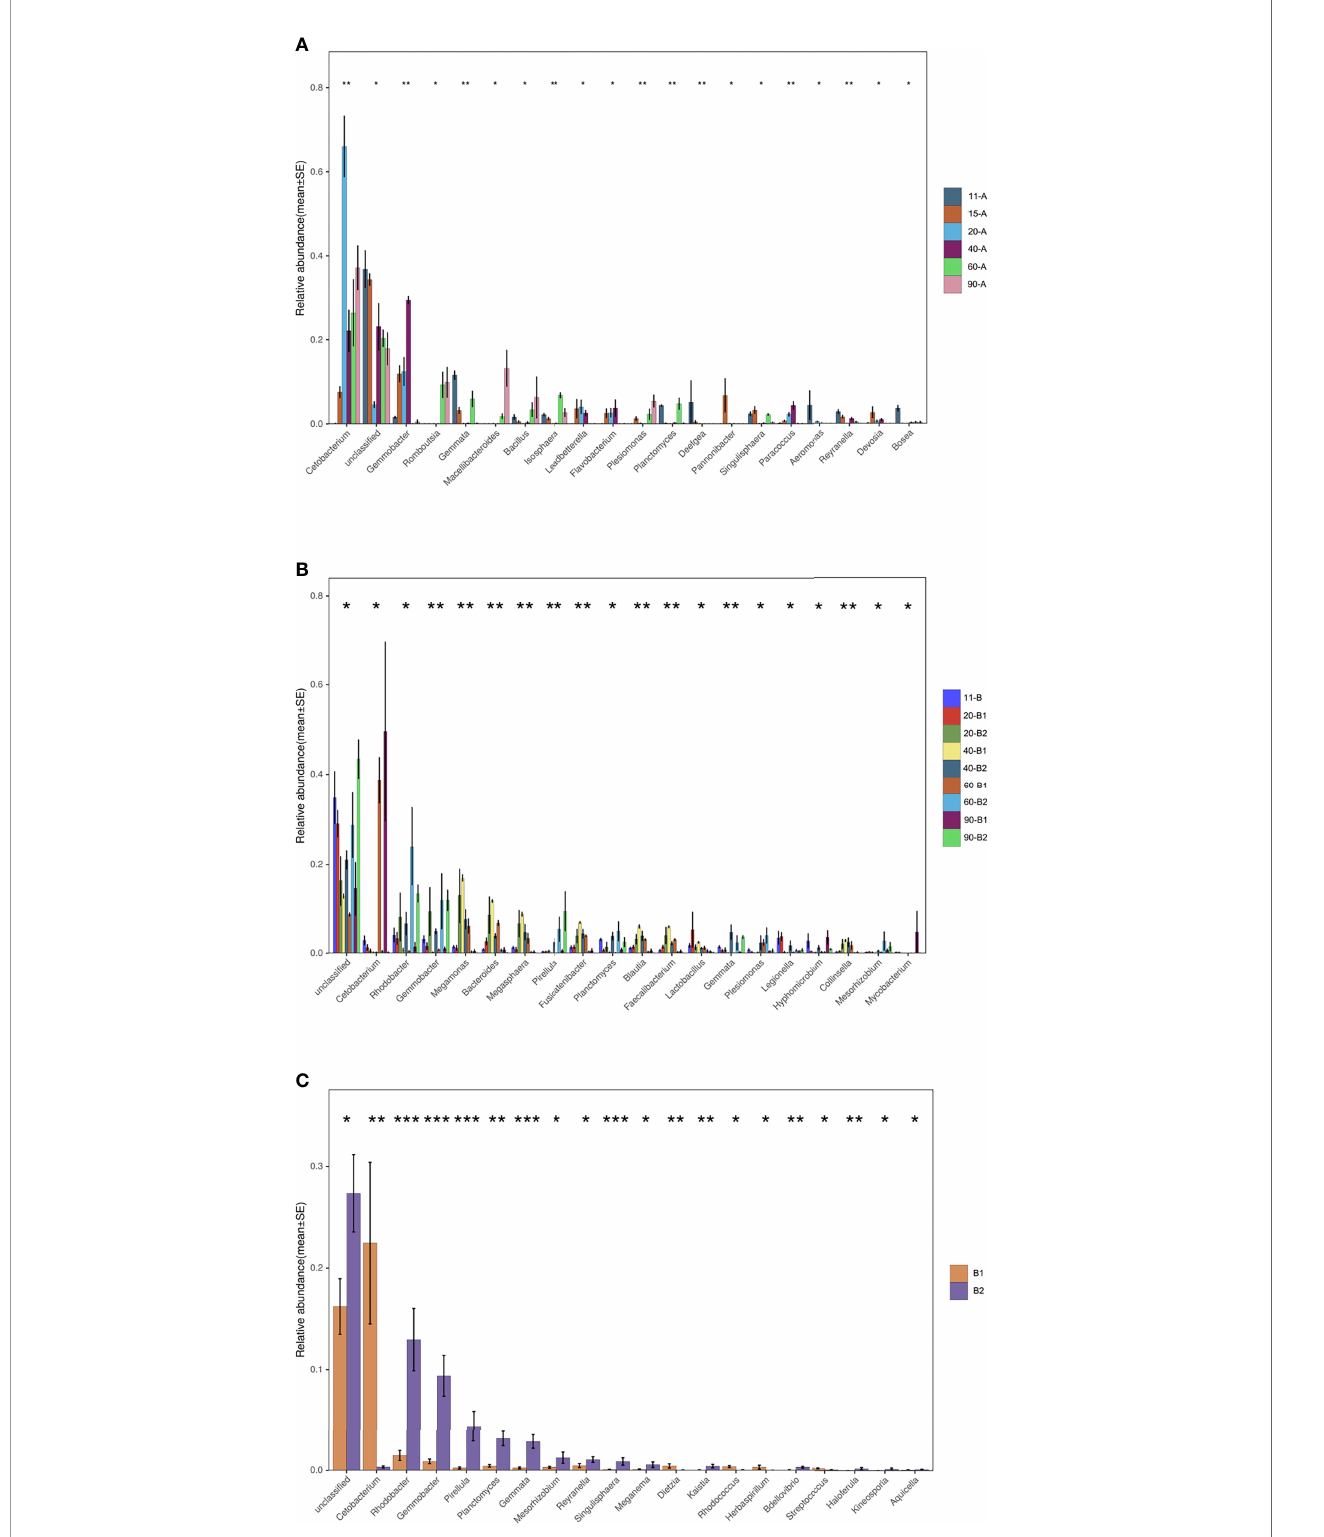
FIGURE 5 | Discriminatory taxa of top 20 at the genus level. (A) Experiment I (n=3), (B) Experiment II (n=3) comparing all samples, and (C) Experiment II comparing between the two diet groups (n=12). * p < 0.05, ** p < 0.01, *** p <